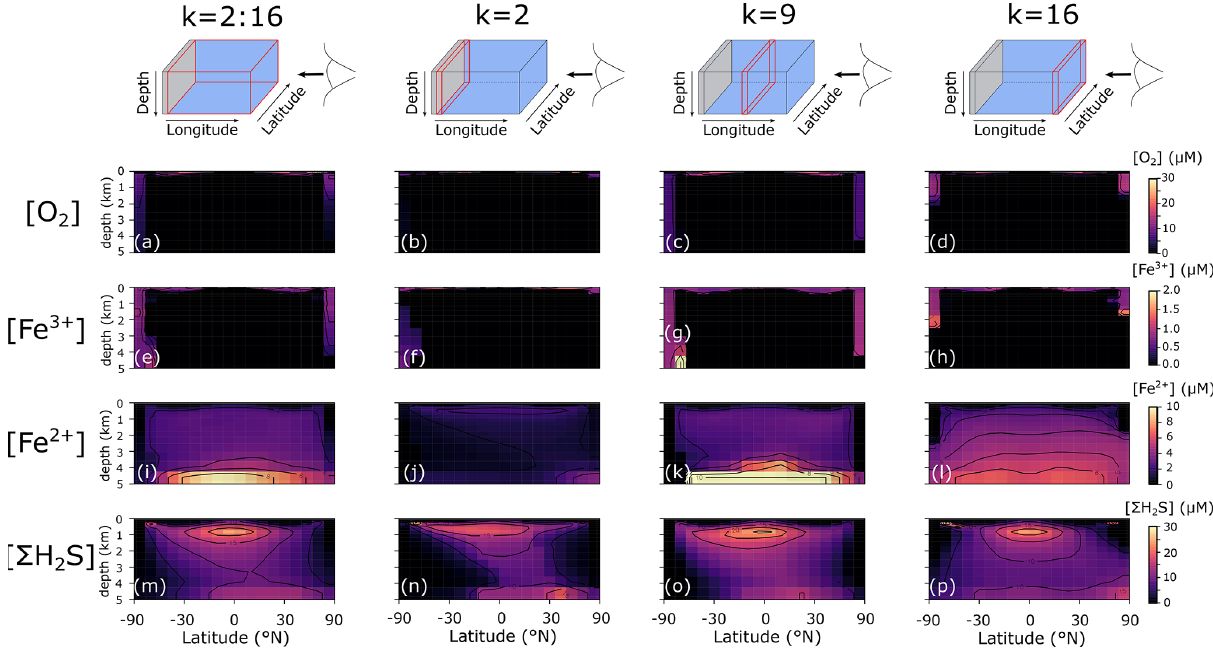
Figure 8. Model output of (a) – (d) dissolved oxygen (O 2 ), (e) – (h) dissolved ferric iron (Fe 3 + ), (i) – (l) total dissolved ferrous iron (Fe 2 + ), and (m) – (p) total dissolved sulfide ( (cid:54) H 2 S) for an ocean with 50% of the modern phosphate inventory (all concentrations: